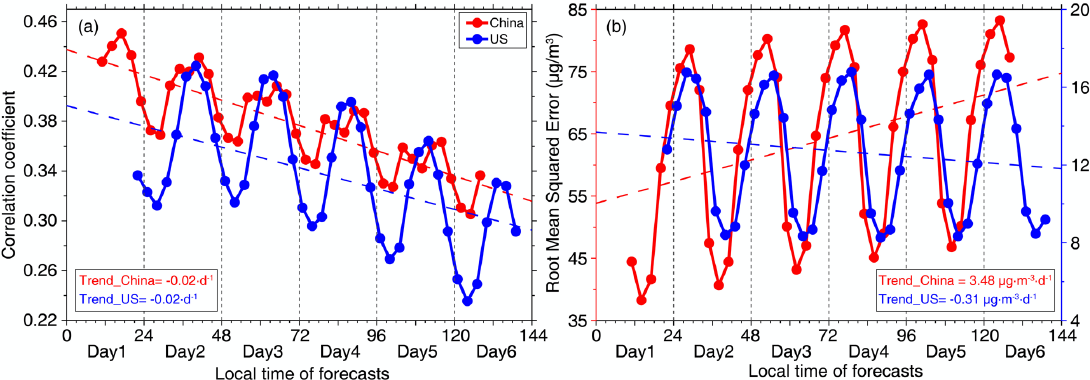
Figure 3. Temporal variations in mean correlation coe ffi cient (R) ( a ) and root mean squared error (RMSE) ( b ) for CAMS PM 2.5 forecasts at each forecasting time step in China and US. The dashed lines in red and blue are least square lines fitted to each metric time series. Note the left axis (red) in Figure 3b refers to RMSE in China while the right axis (blue) is for the RMSE in